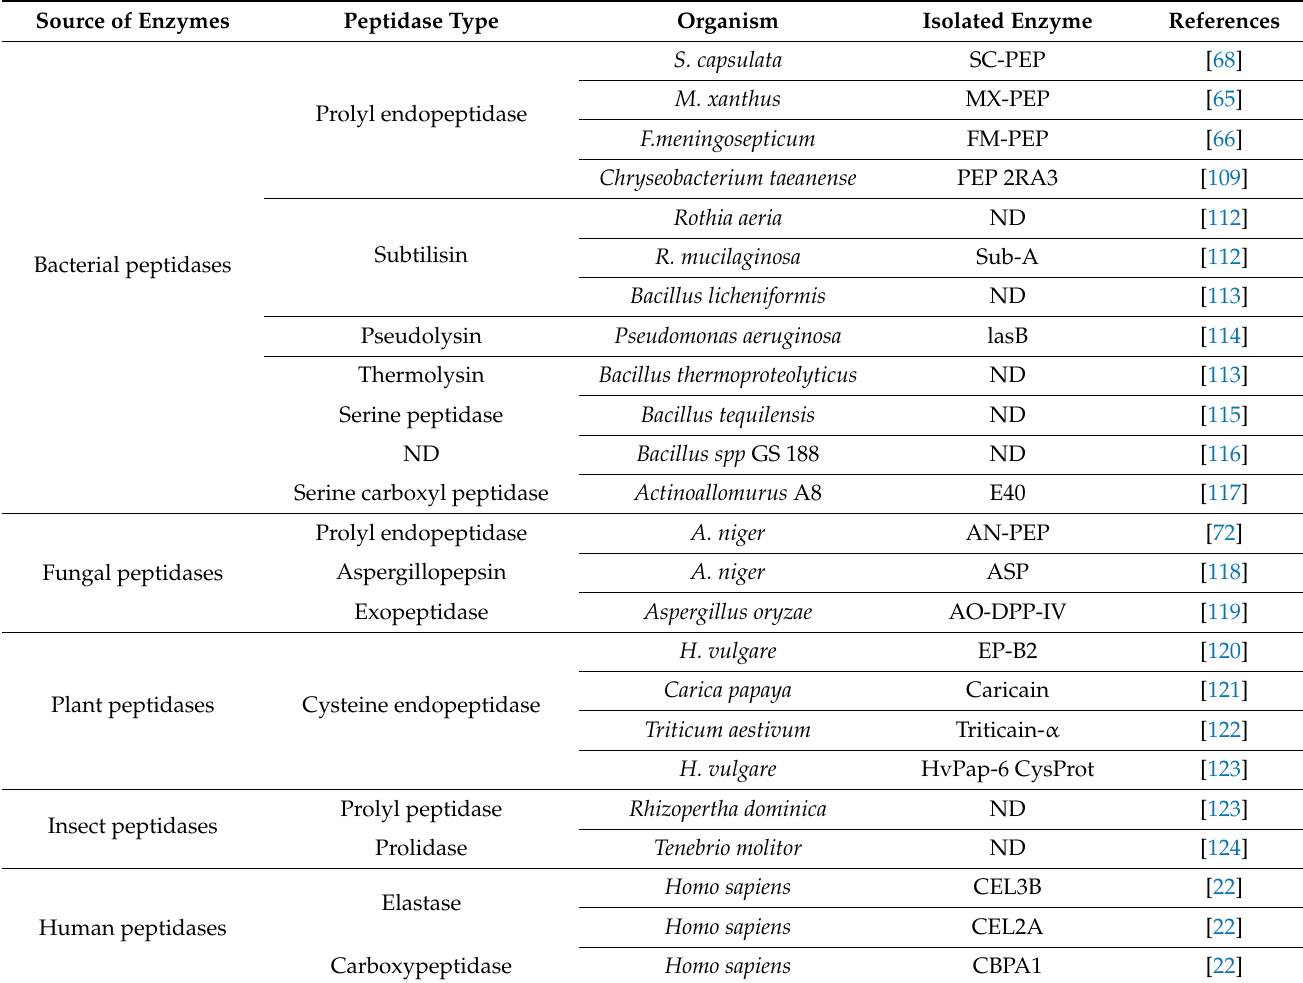
Table 2. Summary of glutenases used in enzyme therapy and classified according to origin of isolation, producer organism, and catalytic mechanism. ND, not